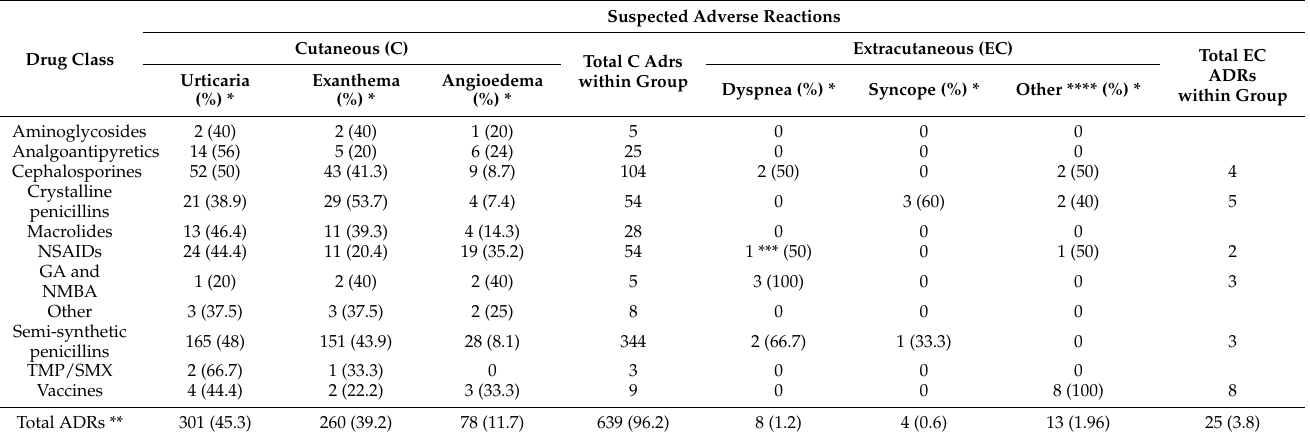
Table 1. Cutaneous and extracutaneous manifestations provoked by suspected drug class (data obtained from patients’ medical histories).